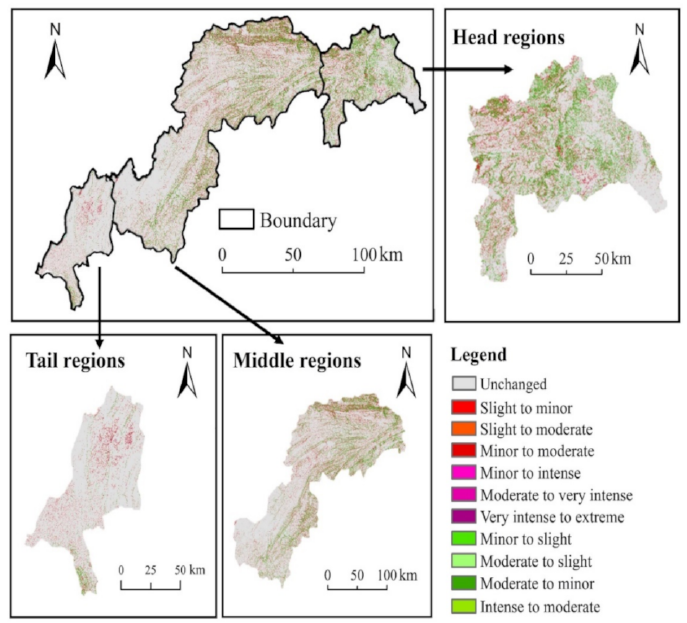
Figure 6. Spatial transition map of soil erosion grade from 1990 to